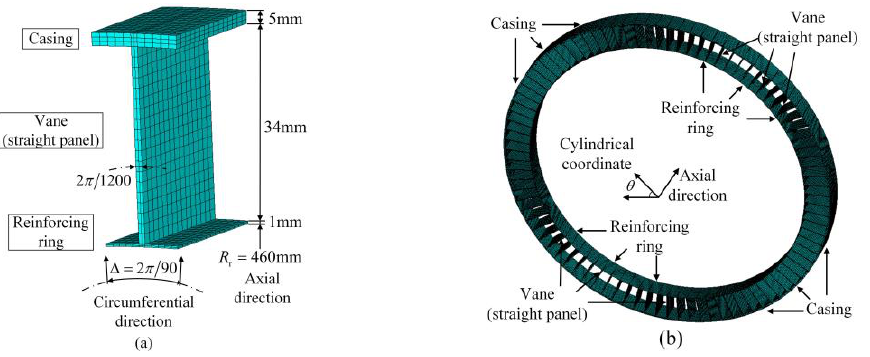
Figure 1. FE model of stator ( a ) a unit cell ( b ) full circle with 90 cells.